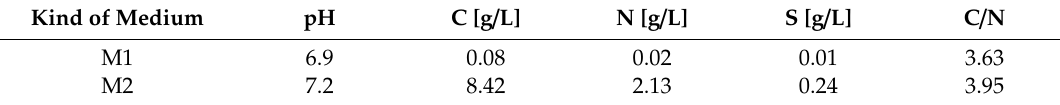
Table 2. Chemical characteristics of culture media used in the study.